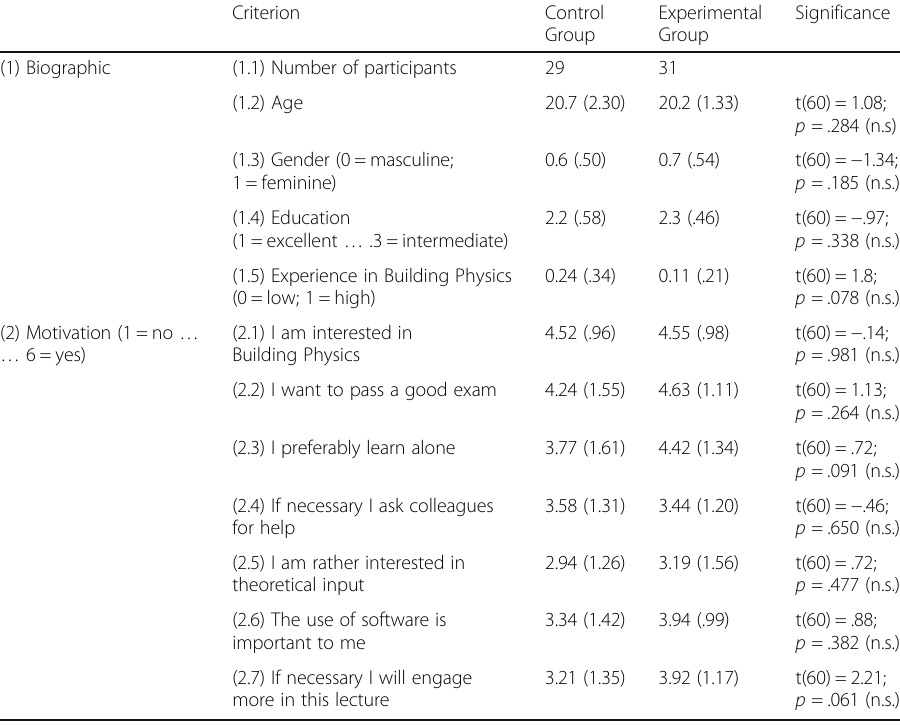
Table 1 Pre-test variables and significance test between both cohorts Criterion Control